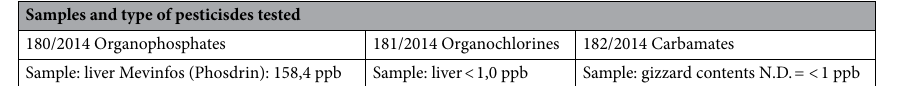
Table 1. Results of toxicological analysis of the liver and gizzard of two hyacinth macaw specimens performed by CEATOX – UNESP, Botucatu, SP.